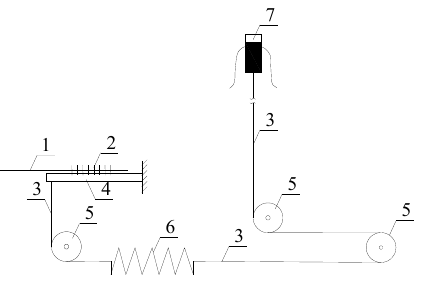
Figure 3. Internal schematic of FBG roof separation sensors: 1—Optical fiber; 2—FBG; 3—Wire rope; 4—Cantilever beam; 5—Fixed roller; 6—Spring; 7—Fixed device.